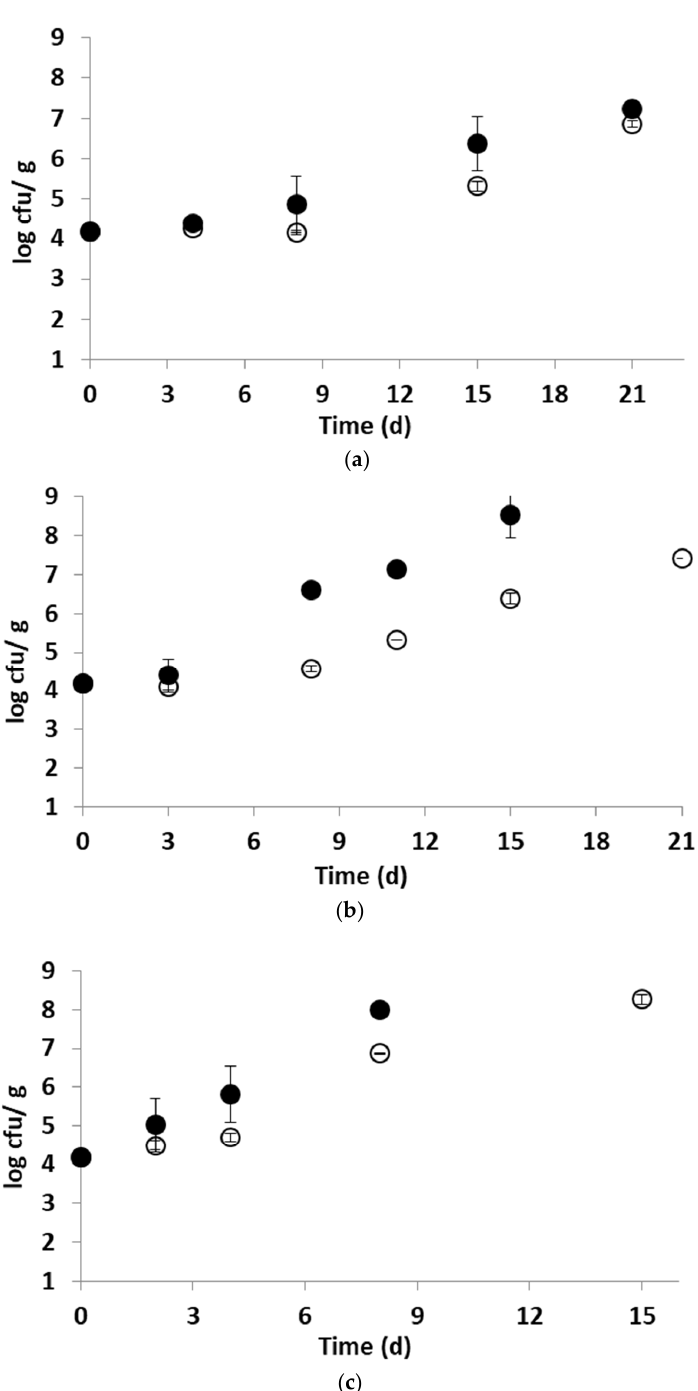
Figure 3. Total viable count in MAP and ACT-MAP sea bass during the isothermal storage at ( a ) 0 °C, ( b ) 5 °C, and ( c ) 10 °C ( ○ ACT-MAP, ● MAP).